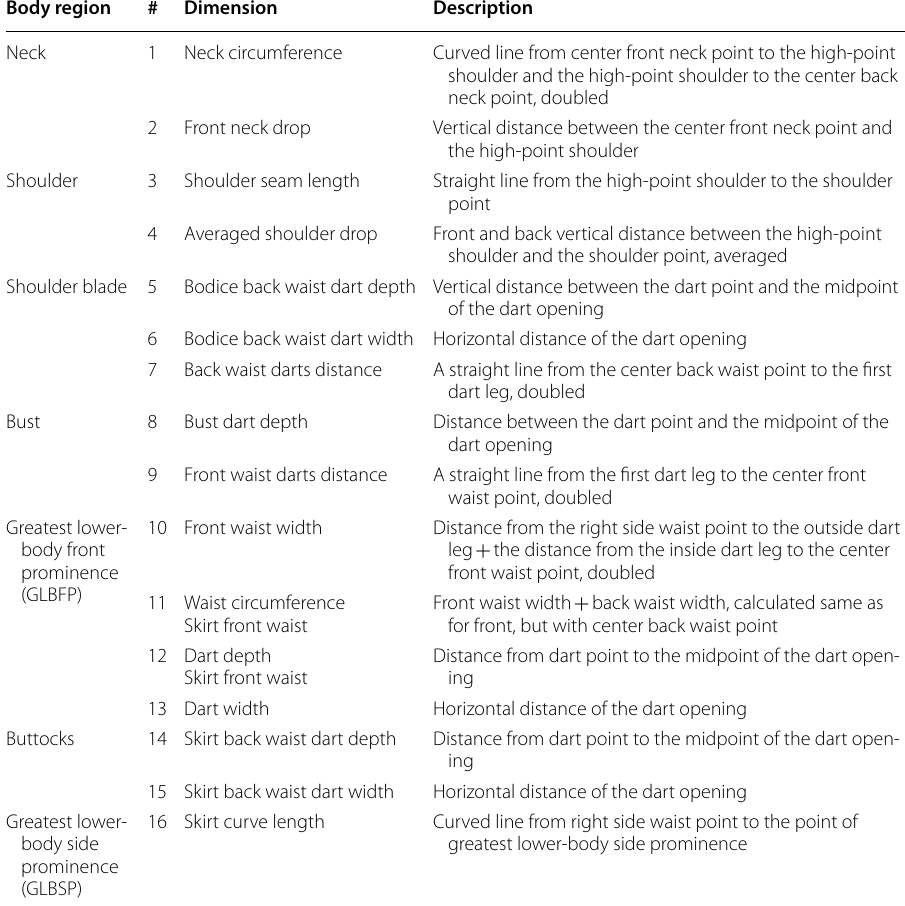
Table 3 Dimensions and accompanying description; sorted by body region Body